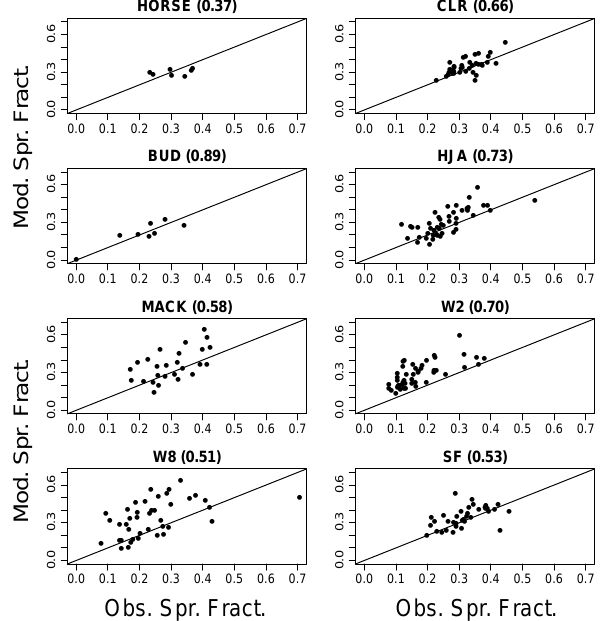
Fig. 6. Correlation between observed and modeled spring fraction of annual flow. Values in brackets are Pearson Correlation Coeffi- cient – all were significant at 99% confidence. Results are shown for a single acceptable parameter set and for all years with ob- served/modeled streamflow (available water years for each water- shed are listed in evaluation column of Table